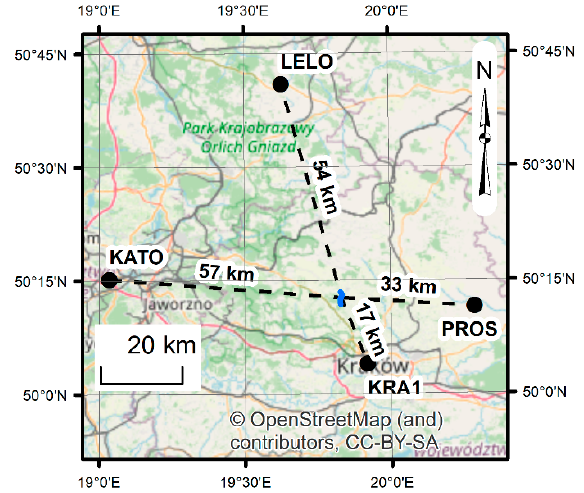
Figure 3. Are of study (blue) and reference stations with distances. Base map: © OpenStreetMap (and) contributors, CC-BY-SA.